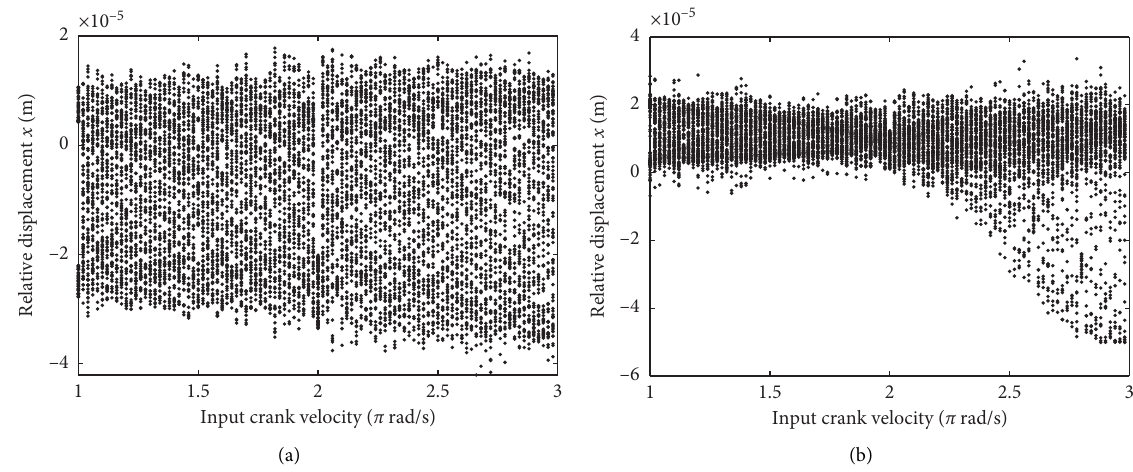
Figure 29: Bifurcation diagram of variable driving velocities of the seven-bar hybrid drive at (a) clearance A and (b) clearance